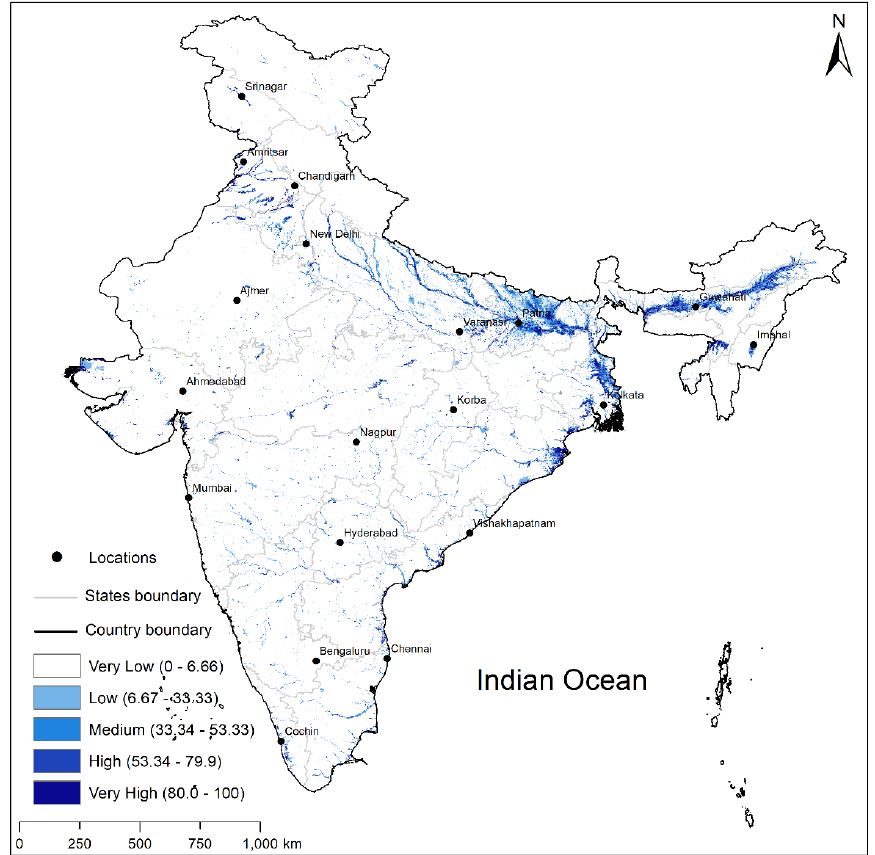
Figure 4. Recurrent flooded areas mapped using MODIS satellite data for India. Table 2. State-wise total Swarna-Sub 1 seed requirement and cost of procuring in INR and